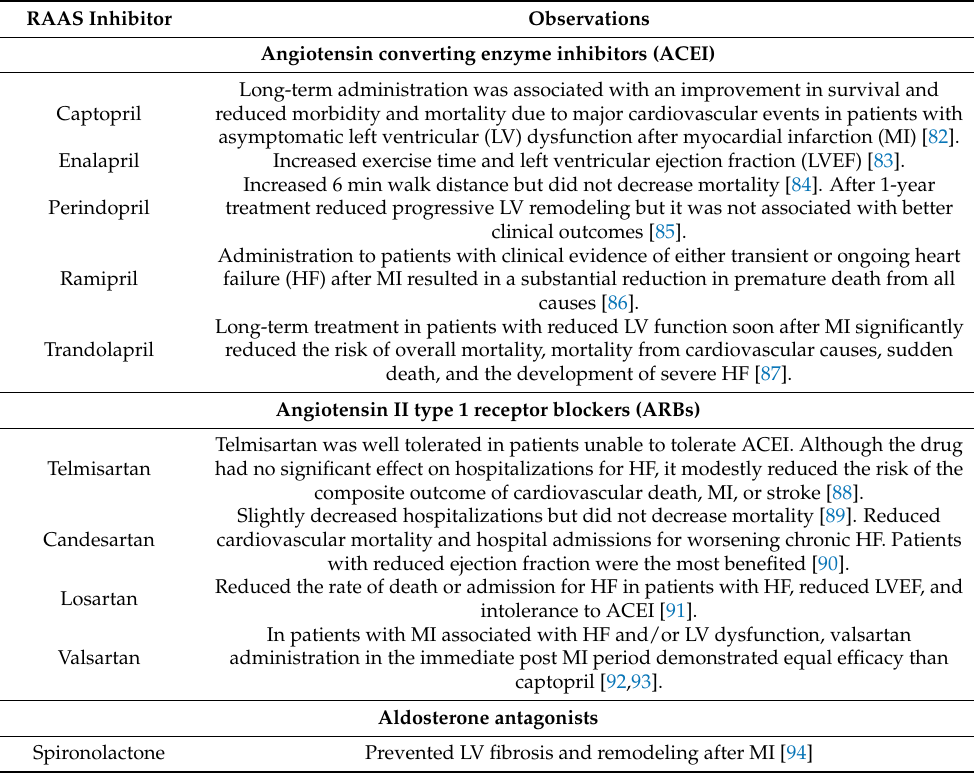
Table 2. Role of RAAS inhibitors in heart